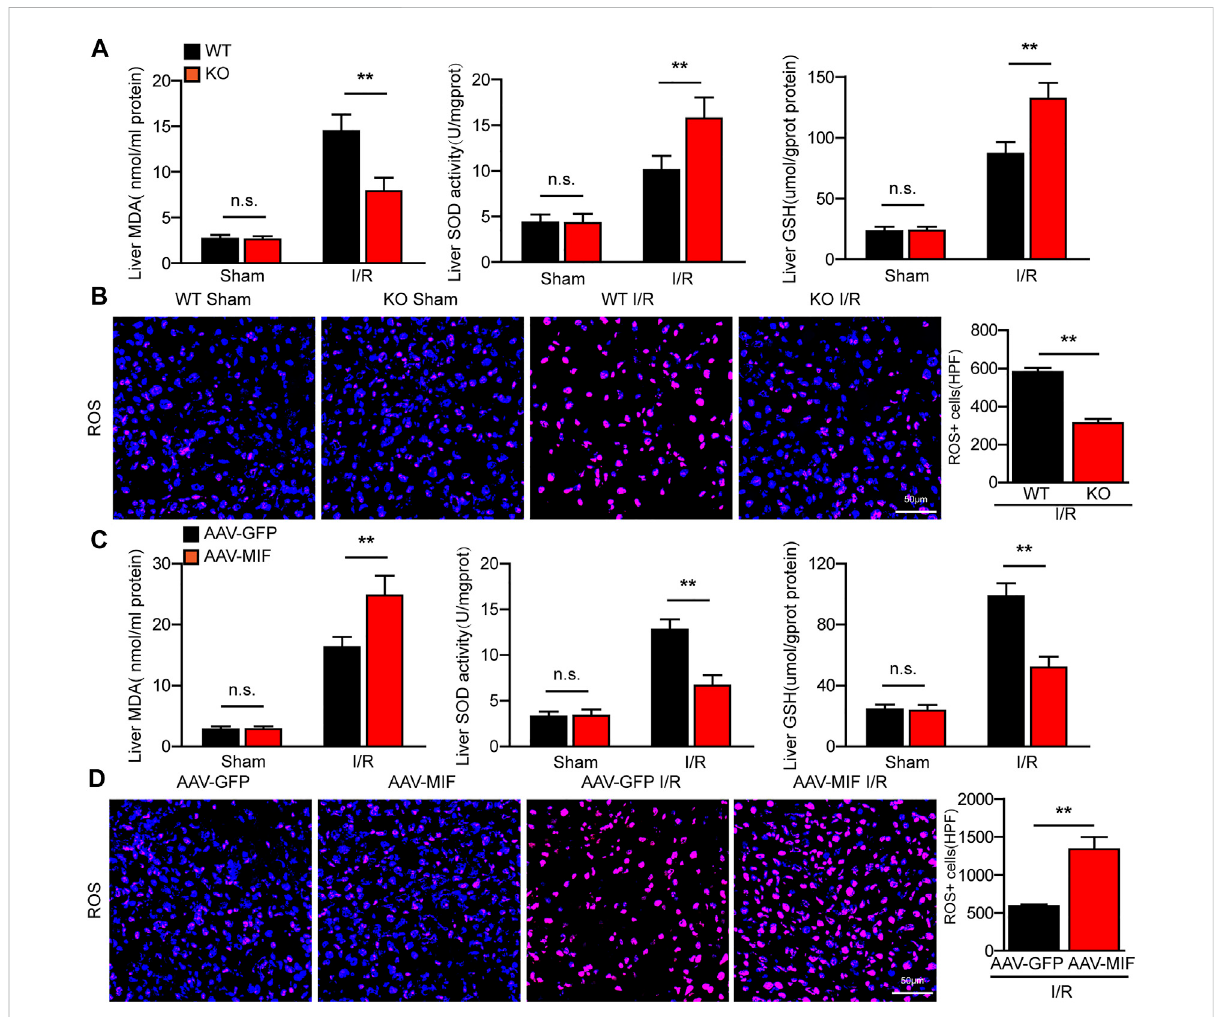
FIGURE 5 MIFablationinhibitsoxidative stressin hepaticI/R injury. (A) ELISA detection ofMDA,SOD and GSHlevel inserum of WTand MIF-KO mice after hepatic I/R surgery ( n = 6 per group). (B) DHE staining in liver sections from WT and MIF-KO mice after hepatic I/R surgery ( n = 4/group). Scale bar, 50 μ m. (C) ELISA detection of MDA, SOD and GSH level in serum of AAV-GFP or AAV-MIF mice after hepatic I/R surgery ( n = 6 per group). (D) DHE staining in liver sections from AAV-GFP or AAV-MIF mice after hepatic I/R surgery ( n = 4/group). Scale bar, 50 μ m. All data are shown as